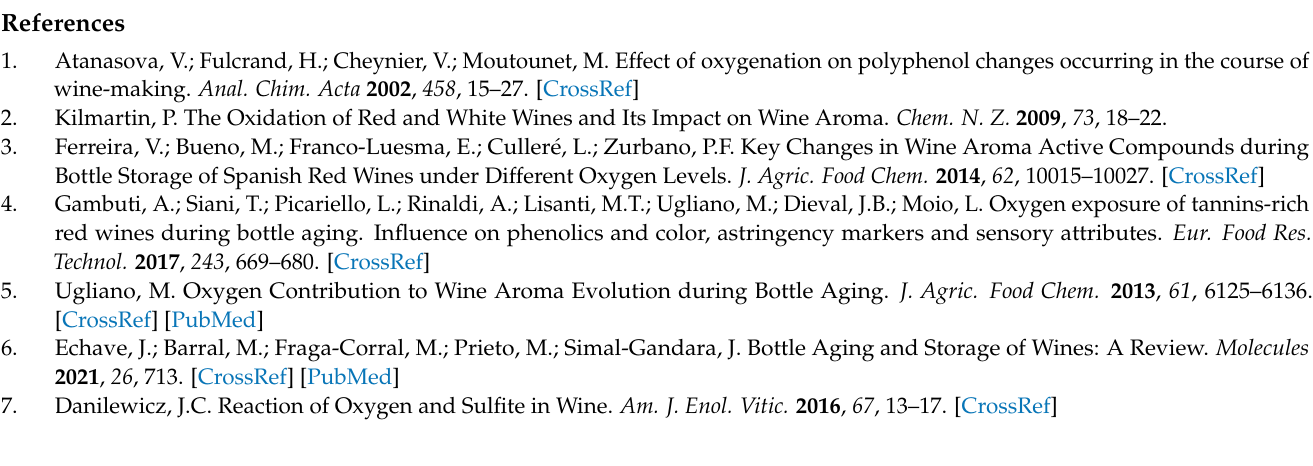
S2: free SO 2 levels in the red wines after the different oxidation tests, Figure S1: representation of the scores (wines) (variables—electrochemical parameters for the reference wines (Q) and oxidized wines by the three protocols minus reference wines ( ∆ Q)) in the plane defined by respectively the first (F1) and second (F2) factor (explained variance: